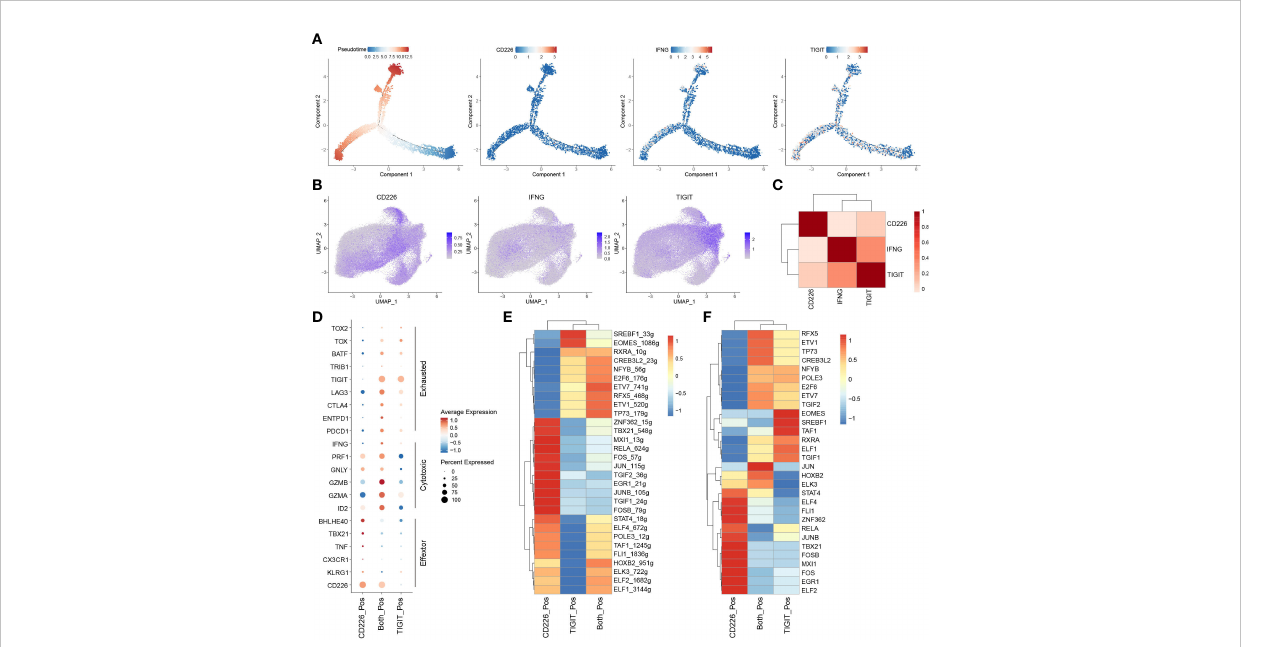
FIGURE 5 IFN- g inhibits the expression of CD226 and promotes T-cell exhaustion. (A) Pseudotime plot of CD8 + TILs in ESCA constructed by R package Monocle2. (B) UMAP showed imputed expressions of CD226 , IFNG , and TIGIT in all CD8 + TILs. (C) Heatmap showed the correlation among CD226 , IFNG , and TIGIT in all CD8 + TILs. (D) Dot plot showed the expressions of selected genes in CD226 + , TIGIT + , and CD226 + TIGIT + CD8 + TILs. (E) Heatmap showed regulon score of selected transcription factors in CD226 + , TIGIT + , and CD226 + TIGIT + CD8 + TILs. (F) Heatmap showed the expressions of transcription factors (shown in E ) in CD226 + , TIGIT + , and CD226 + TIGIT + CD8 +